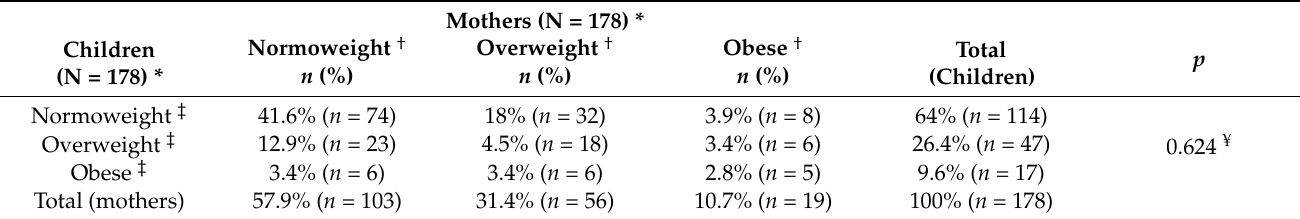
Table 2. Pairs of mothers and children in each weight status category (%, n ).